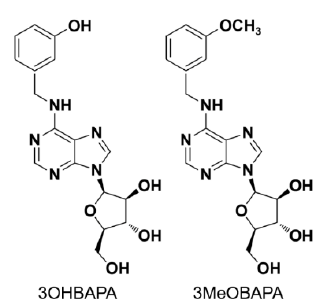
Figure 1. Structure of 6-(3-hydroxybenzylamino)-9- β - D -arabinofuranosylpurine (3OHBAPA, left) and 6-(3-methoxybenzylamino)-9- β - D -arabinofuranosylpurine (3MeOBAPA, right).